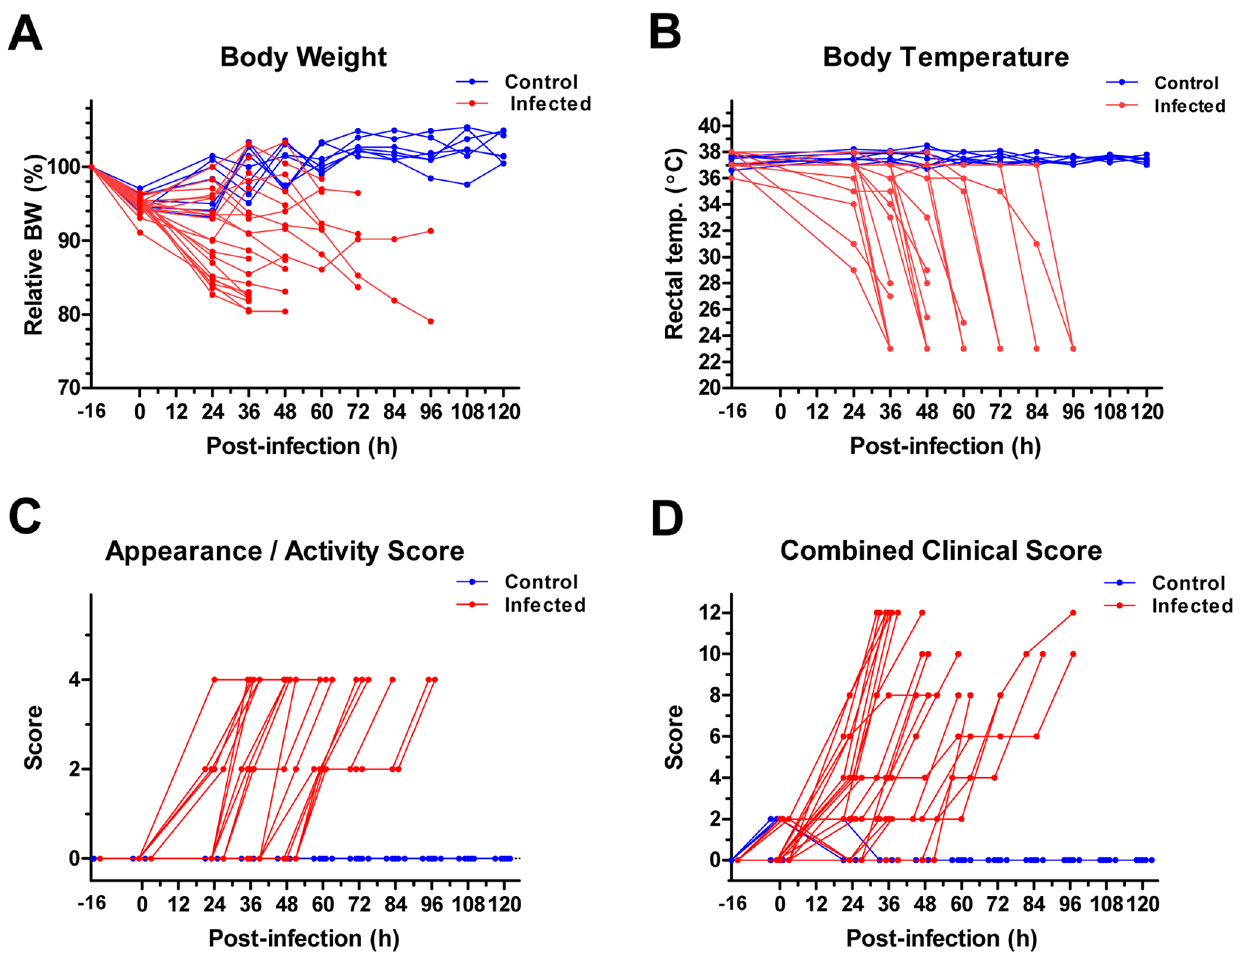
Figure 2. Gastrointestinal anthrax has time-dependent effects on various clinical parameters. Mice were fasted for 16 h and subsequently treated with , 10 9 intragastric BaS or PBS control. Body weight (BW), body temperature (BT), and appearance/activity were assessed prior to the fasting period and were subsequently monitored every 12 h until the animals became moribund, died, or reached the termination of the experiment (120 h). BW values for each animal were normalized to their baseline weights, which were assigned the value of 100% ( A ). BTs for each animal were assessed via a digital rectal thermometer ( B ). Appearance/activity for each animal was scored as follows: no change: (0 points); decreased locomotion, ruffled fur (2 points); and isolation, minimal spontaneous locomotion (4 points) ( C ). Combined clinical scores for each animal are shown in D . These scores were calculated from the 3 parameters described above. BW scores were assigned as follows: , 5% change (0 points), $ 5%, but , 10% (2 points), and $ 10% (4 points). BT scores were scored as follows: rectal temperature $ 35 u C (0 points), body temperature , 35 u C, but $ 30 u C (2 points), and body temperature , 30 u C (4 points). These scores were added to the appearance/activity score to provide the combined clinical score, with 12 representing the maximal possible clinical